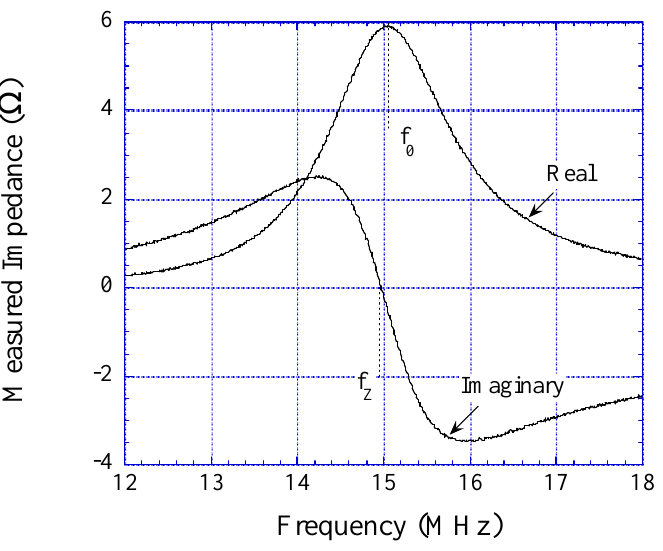
Figure 3. An illustrative measured impedance spectrum of the sensor-perturbed antenna, after subtracting the background antenna impedance. The resonant frequency f maximal of the real portion of the impedance, and the zero-reactance frequency f crossing of the imaginary portion of the impedance